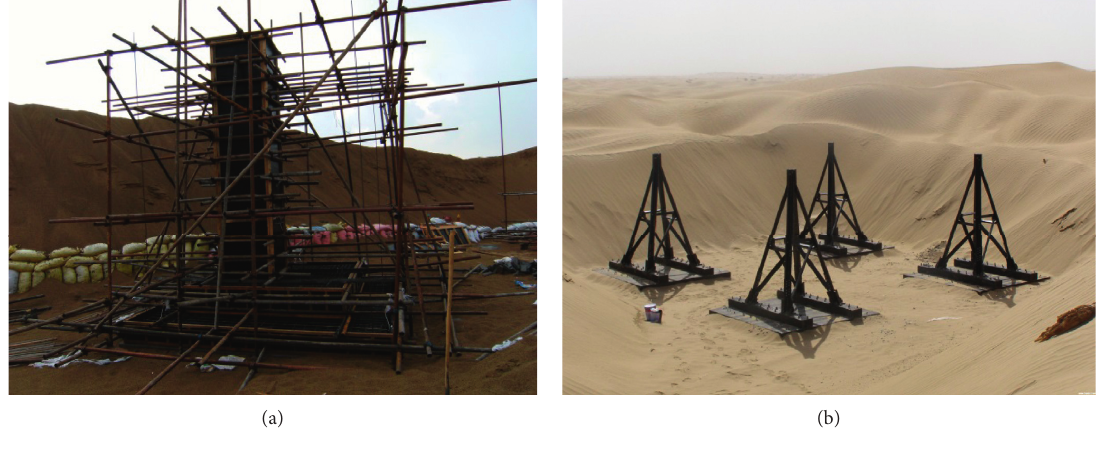
Figure 1: Foundation construction in